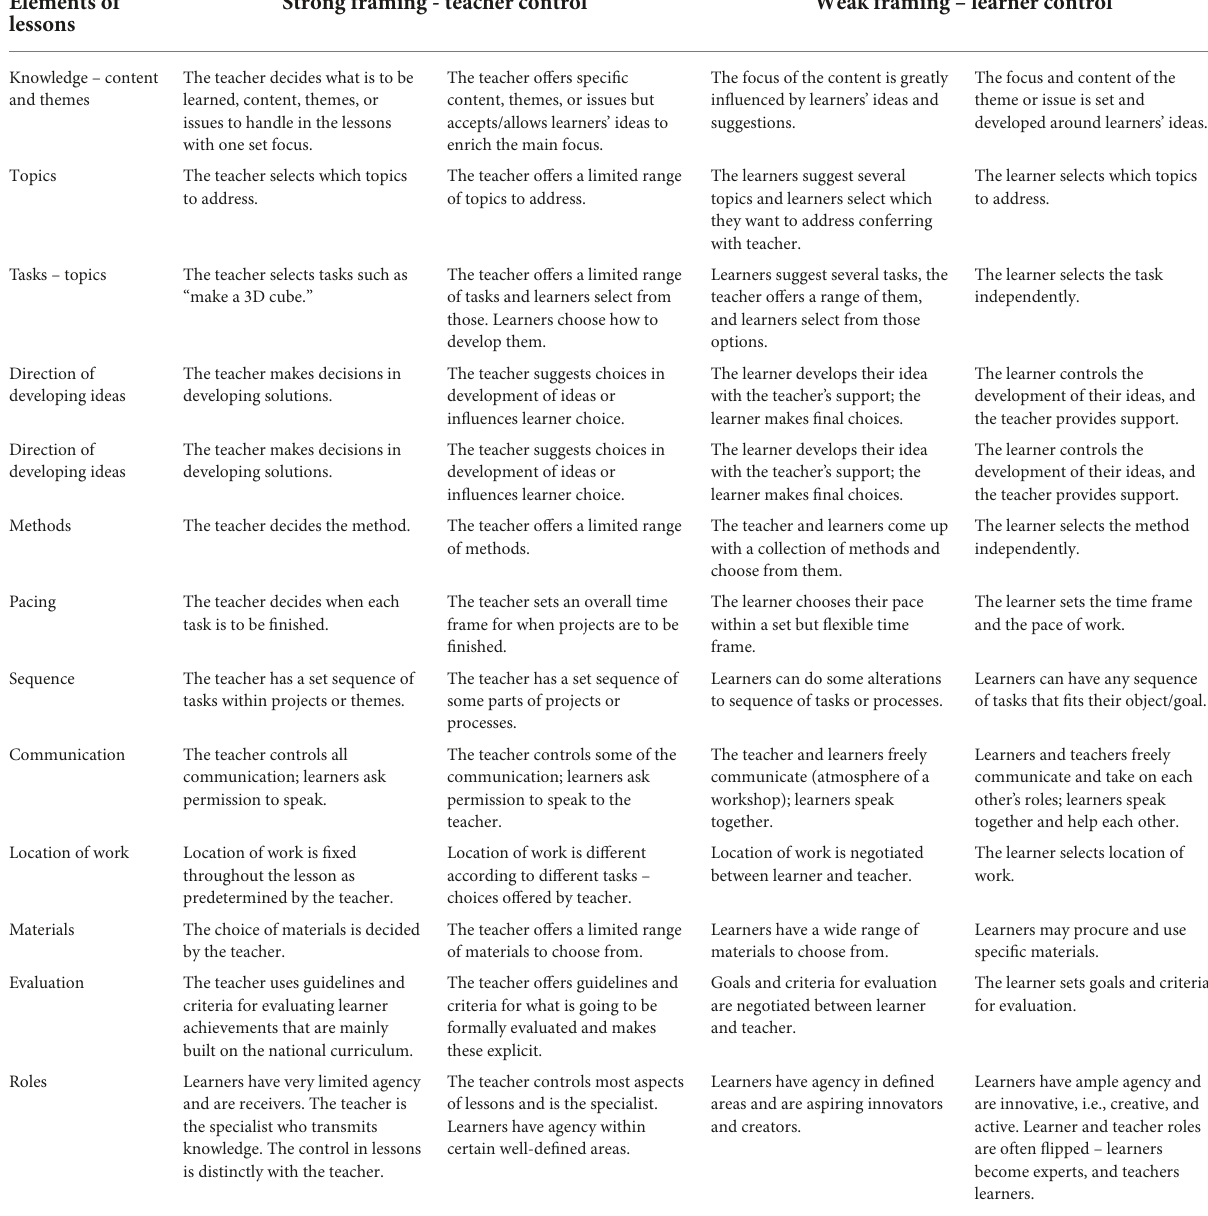
TABLE 2 Developing the framing